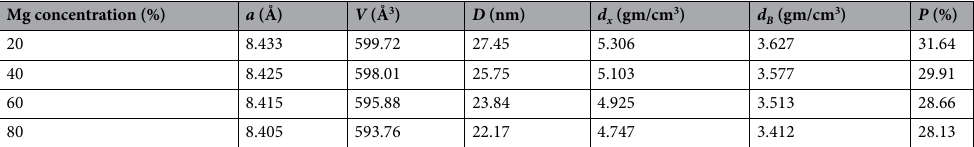
Table 2. Values of Lattice parameter ( a ), Unit cell volume ( V ), Average crystallite size ( D ), X-ray density ( d x ), Bulk density ( d